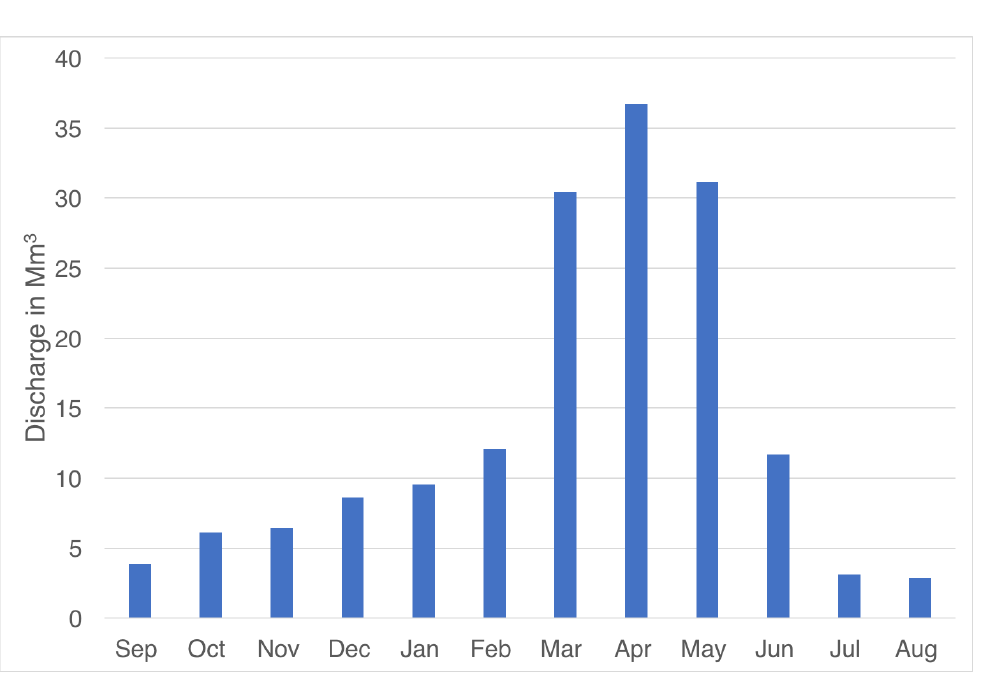
Figure 2. Mean monthly discharge of the Ourika River at Aghbalou (1970–2003